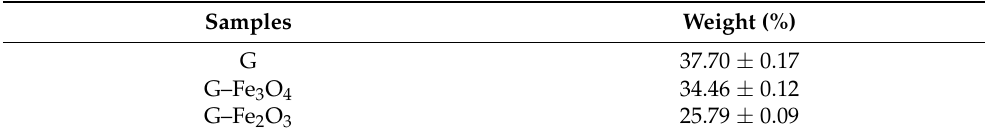
Table 3. Parameters obtained based on sorption/desorption isotherms (water vapor sorption capacity- weight-moisture content (%).